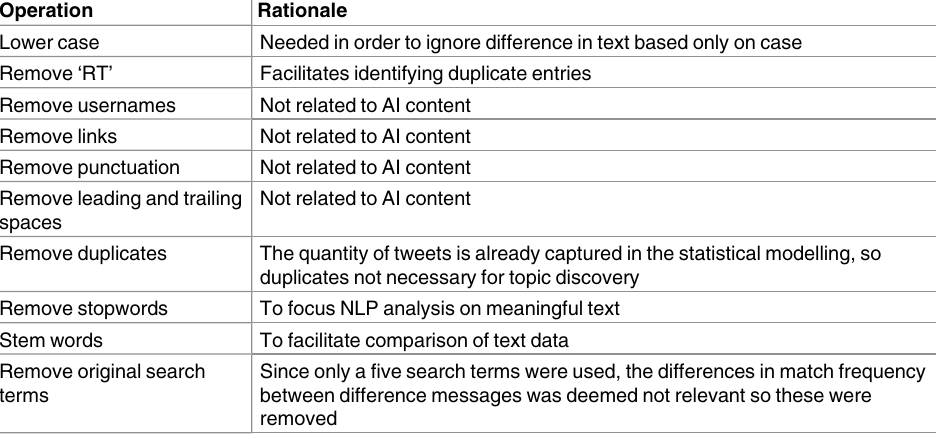
Table 2. Data cleaning operations performed on Tweets prior to Latent DIrichlet Allocation topic